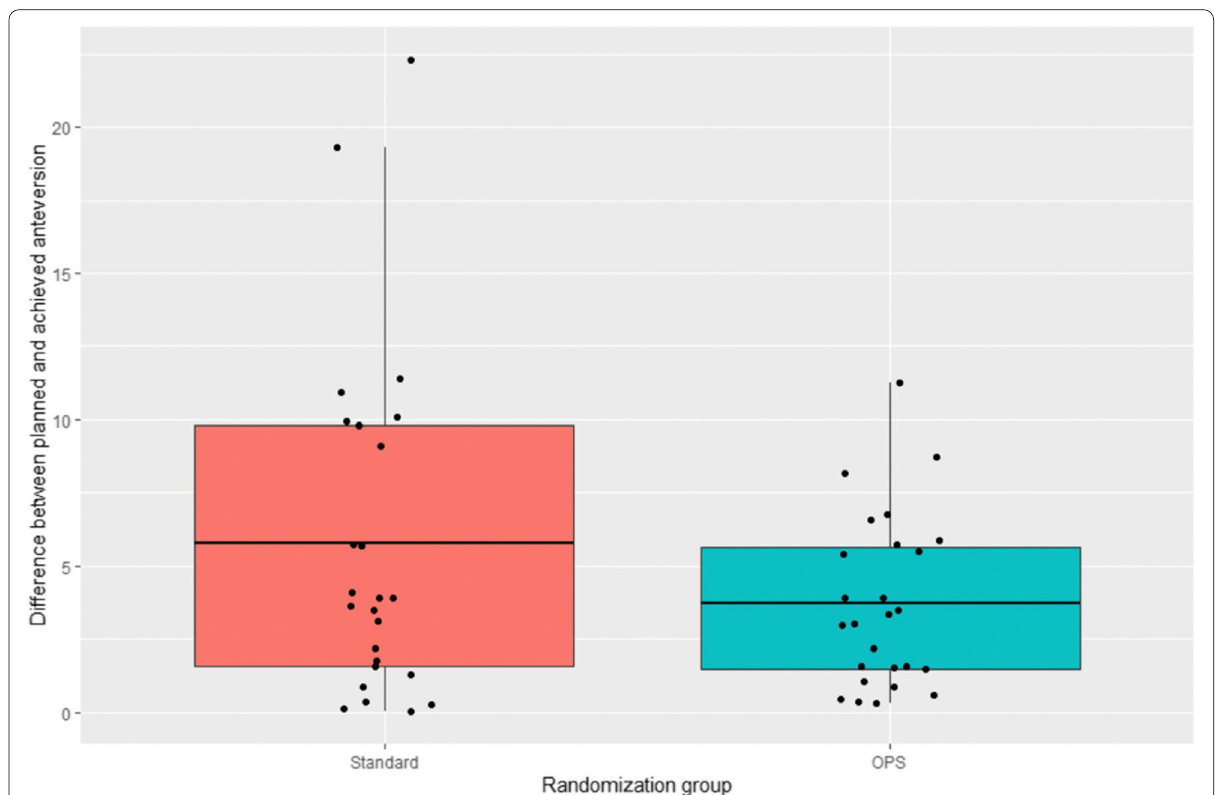
Fig. 6 Box and Whisker plot of acetabular planned vs . achieved implant position in conventional and Corin OPS